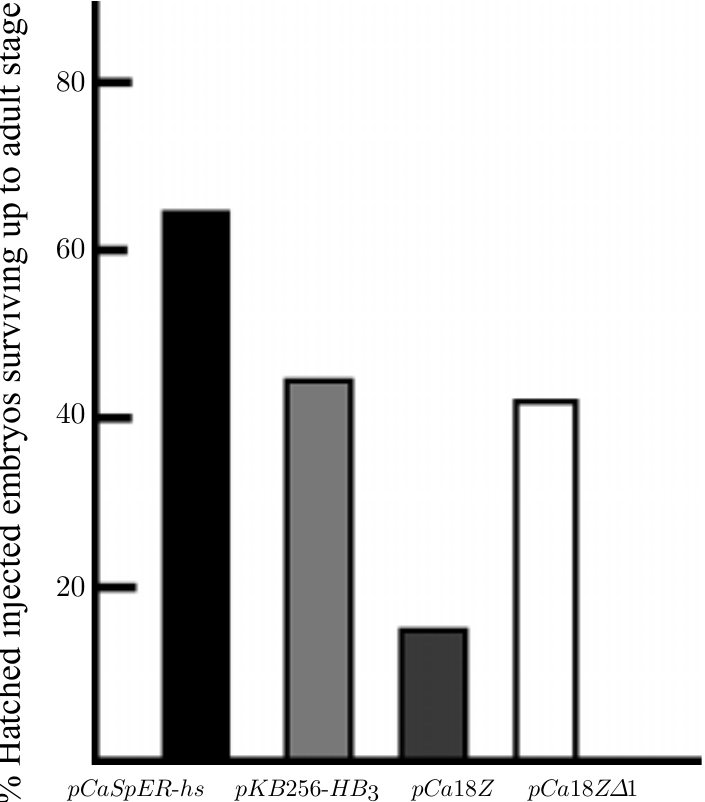
Fig. 4 – Percentage of adults eclosed from the surviving larvae obtained in the ex- periment shown in figure 3. The individuals injected with pCa18Z showed the lowest eclosion rate, but the other two rst-irreC constructs, pCa18Z (cid:2) 1 and pKB256-HB3 also seem to be able to decrease post embryonic viability, although not as severely as